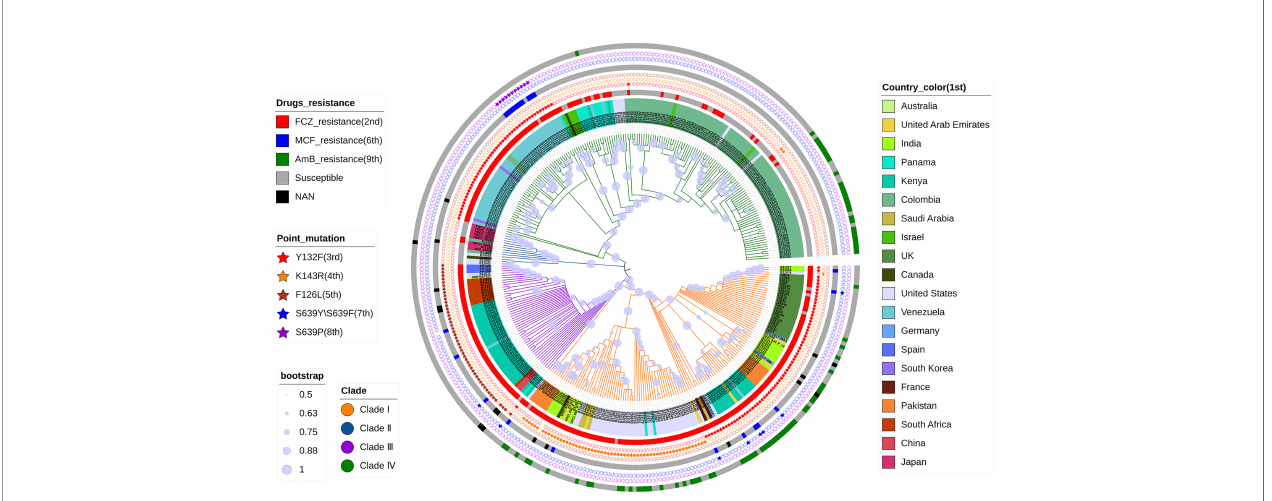
FIGURE 1 | Phylogenetic NJ tree based on WGS of C. auris . The tree describes the phylogeny of 356 strains of C. auris from different regions, divided into four clades. The 1 st to 9 th indicates a concentric circle from the inner-most to the outer-most, respectively. It also shows the correlation between the resistance of these strains to FCZ, AmB, and MCF and the reported point mutations with Y132F, K143R, and F126L in ERG11 , S639Y/S639F, and S639P in FKS1 .